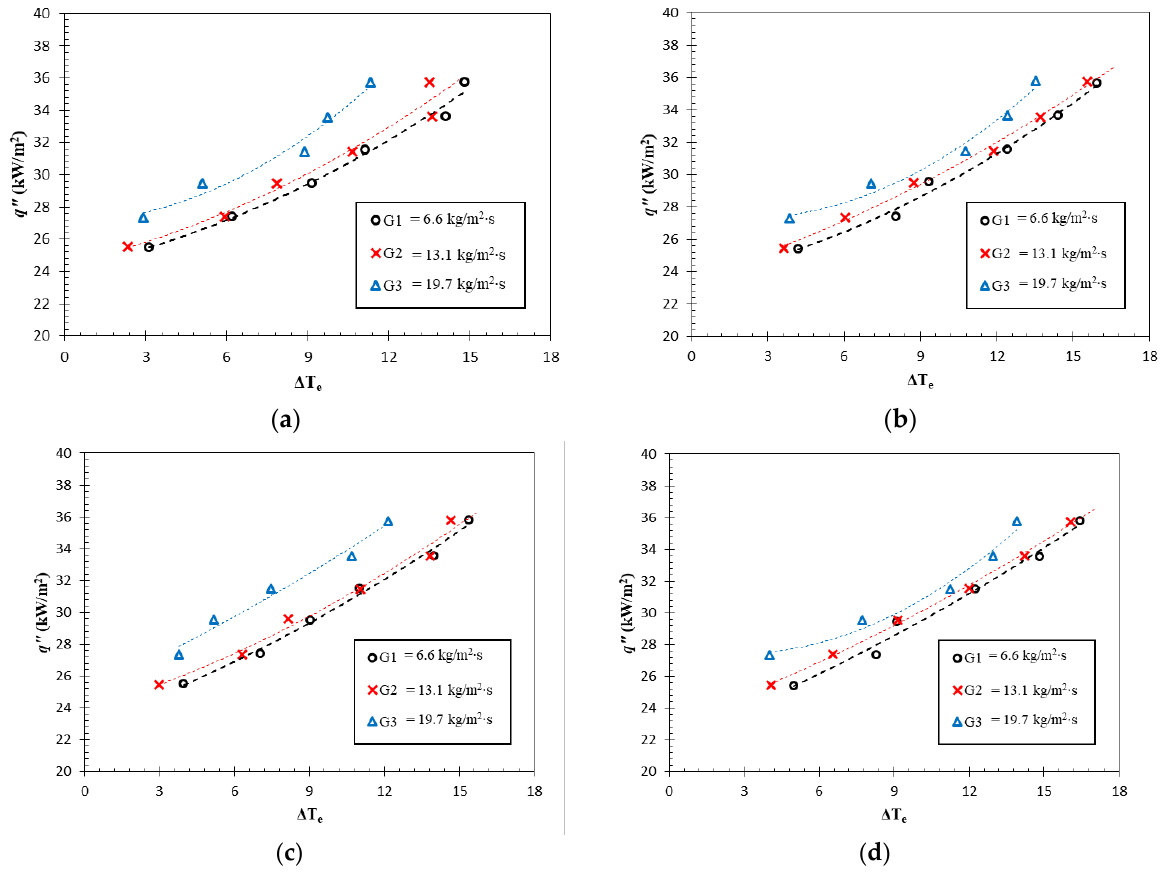
Figure 4. Boiling curves of test case ( a ) R1, ( b ) R1.5, ( c ) T1, and ( d ) T1.5.